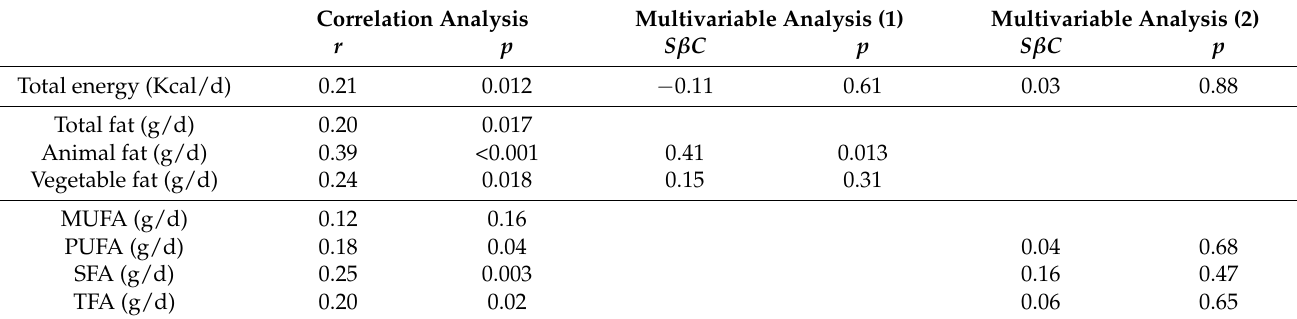
Table 3. Correlation and multivariable analyses of the relationship between UACR (mg/g) and energy and dietary fats. Correlation